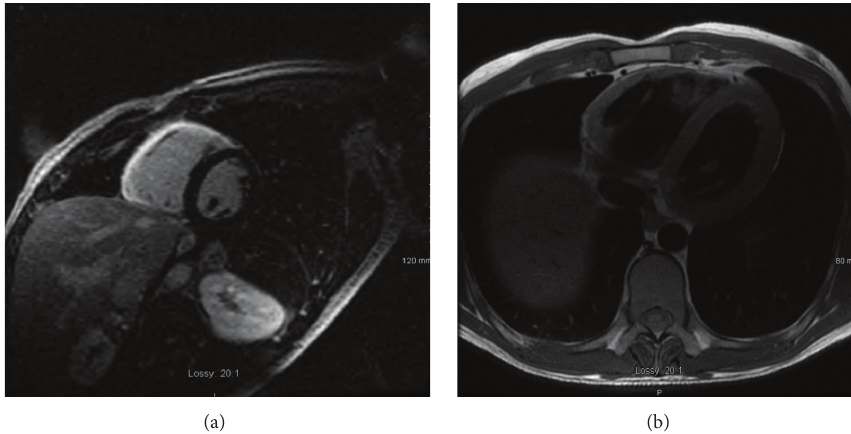
Figure 2: (a) Hyperemia on T1 weighted after gadolinium. (b) Fibrosis on transmural late gadolinium